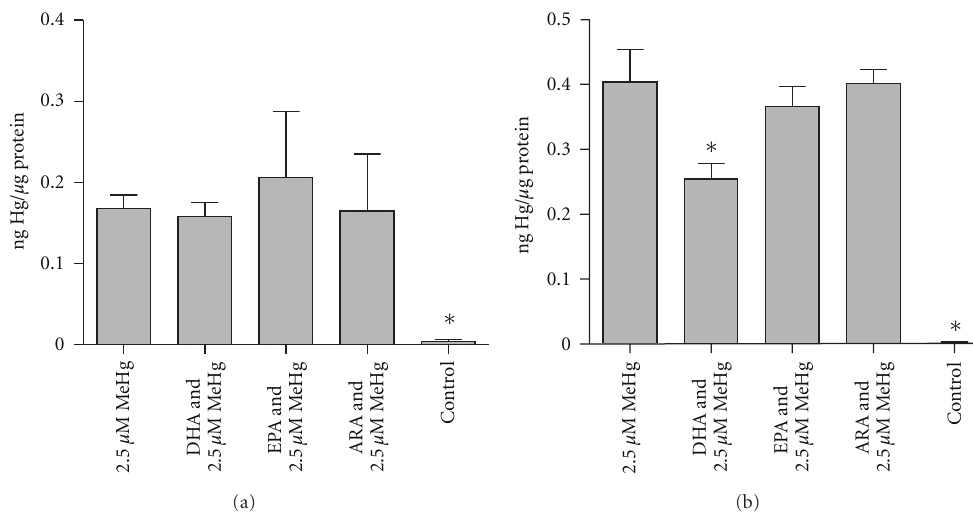
Figure 2: Uptake of MeHg after FA preincubation in ASK cells (a) and HEK cells (b). Results are presented as mean ± SD. Statistical di ff erences are revealed by one-way ANOVA and post hoc Dunnett’s test where n = 4, except for Hg- where n = 3. Significant di ff erences compared to 2.5 μ M MeHg ( P ≤ 0 . 05) are indicated by